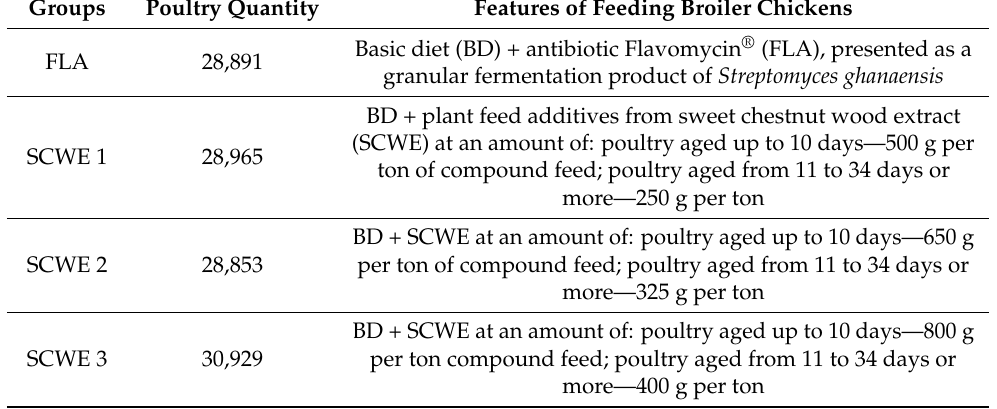
Table 1. Feeding scheme and research